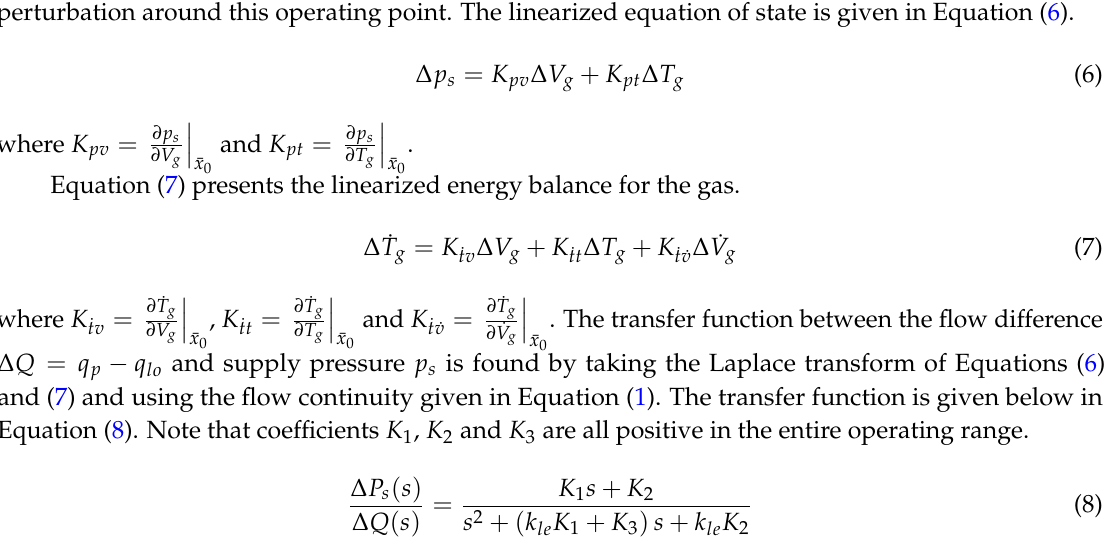
Figure 3. Frequency response for transfer function operating point is set to ¯ x 0 =